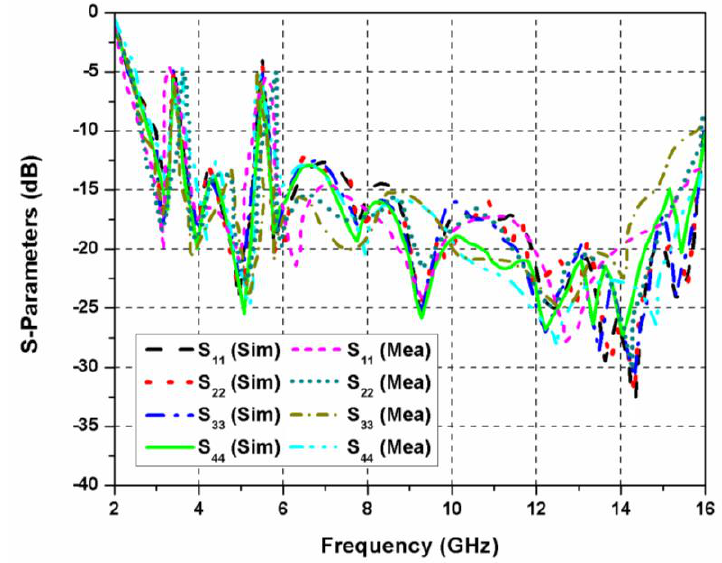
Figure 7. S-parameters (simulated and measured) of the MIMO antenna.